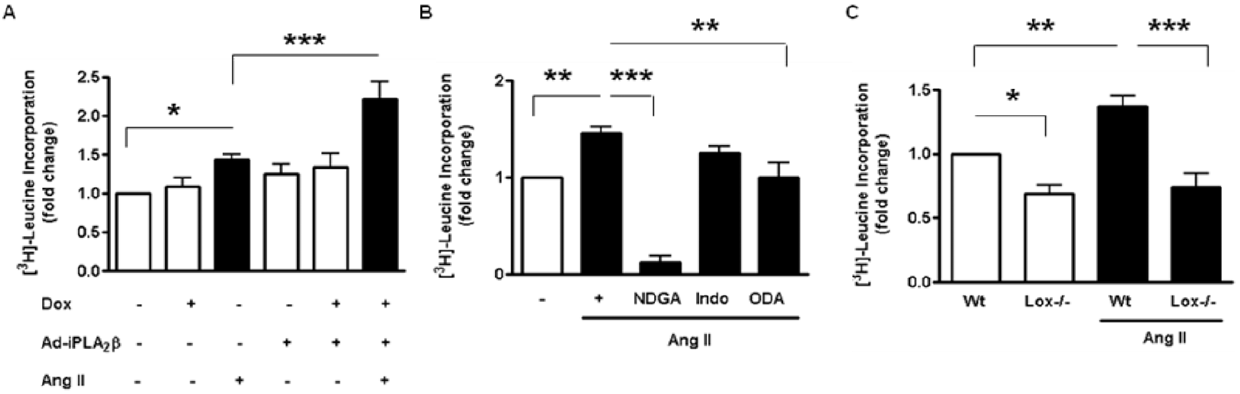
Figure 5. iPLA 2 b overexpression promotes Ang II-induced [ 3 H]-leucine incorporation in VSMC via the 12/15 lipoxygenase pathway. [ 3 H]-leucine incorporation was quantified by liquid scintillation spectroscopy in cultured iPLA 2 b -Wt VSMCs treated with Ang II (100 nM, 24 h) or saline after ( A ) Ad-iPLA 2 b (500 MOI) and Ad-tet-on (2000 MOI), and/or doxycycline (1 m g/ml); ( B ) saline or inhibitors of lipoxygenase (NDGA, 30 m M), or cyclooxygenase (Indomethacin, 50 m M) or P450 cytochrome C (ODA, 10 m M). ( C ) Lox 2 / 2 or Wt VSMCs stimulated with Ang II or saline. n=3–4, *: p , 0.05, **: p , 0.01, ***: p , 0.001 one-way ANOVA.